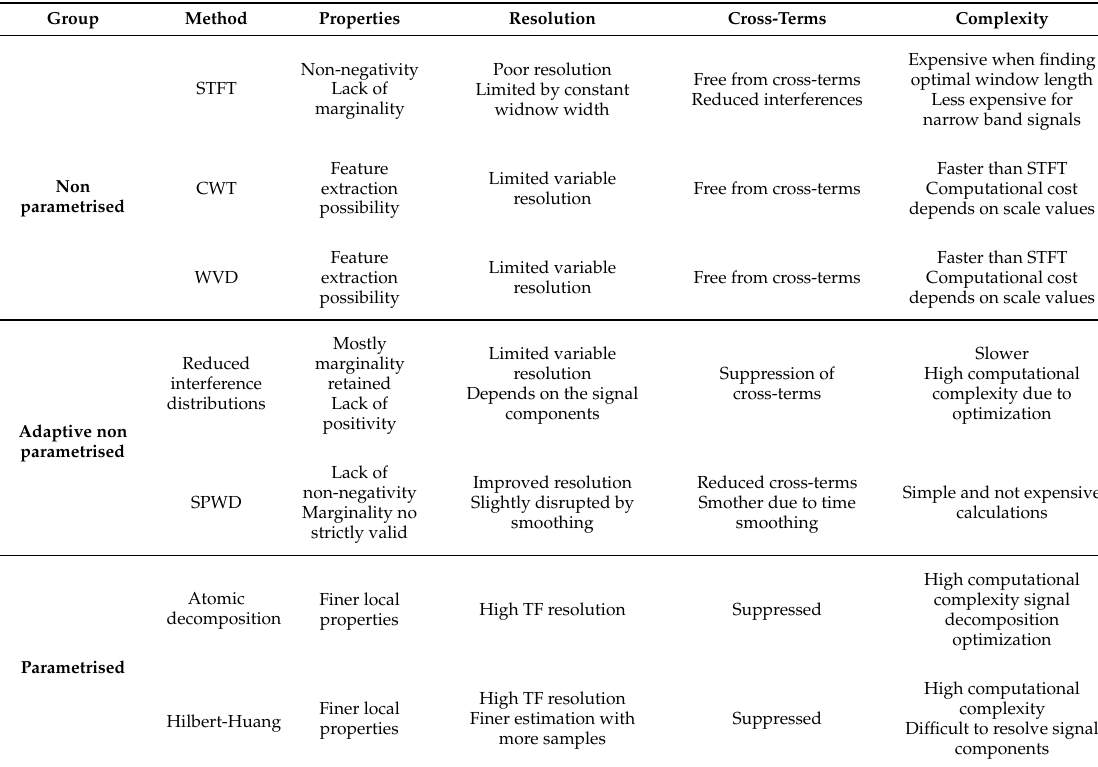
Table 2. Comparative representation of TF distribution